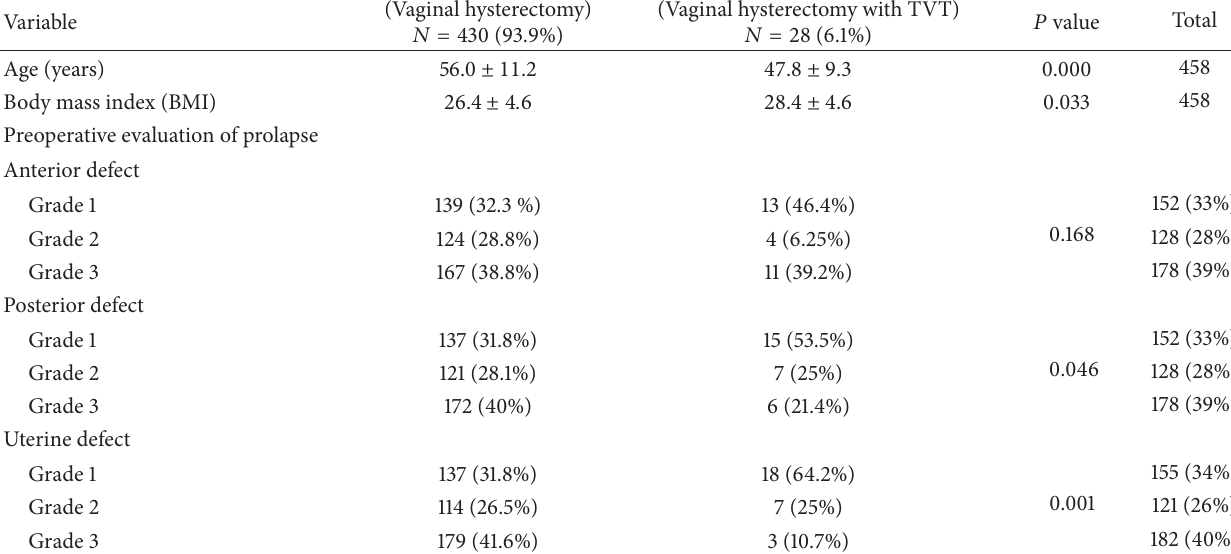
Table 1: Characteristics of cases (vaginal hysterectomy with TVT) and controls (vaginal hysterectomy).